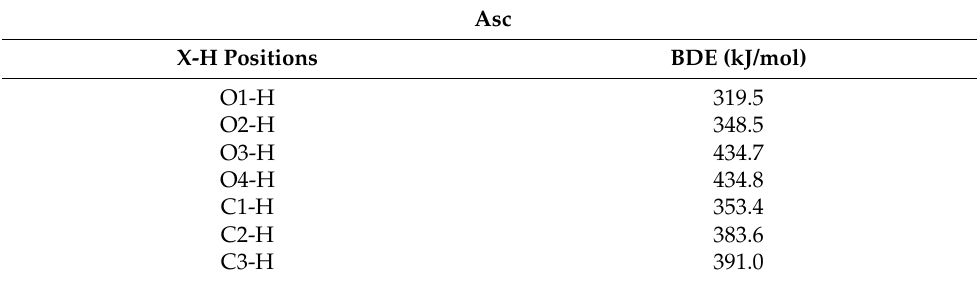
Table 2. Bond dissociation enthalpy (BDE) values (in kJ/mol) for all C-H and O-H bonds of ascorbic acid (Asc) at the M06-2X/6-311++G(2d,2p) level of theory in gas phase. Asc